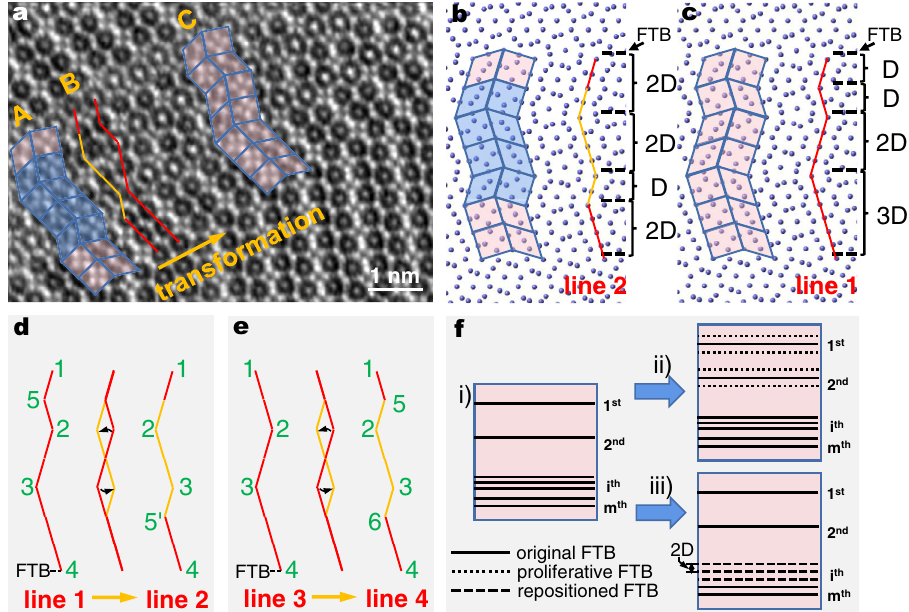
Fig. 5 The HAADF image and schematic illustration of the thickening process of intergrowth P phase. a The HAADF image projection along [1-10] μ showing the thickening process of intergrowth P phase. The orange arrow in ( a ) marks the direction of the progressive transformation. Regions A – C corresponds to the three sequential stages of transformation. b , c Atomic models corresponding to the regions A and C in ( a ), respectively. The differences between the atomic arrangement in region A and that in region C are indicated by the blue block layer (thickness of 4D) in ( b ). The black dashed lines mark the interface position of the FTBs in ( b , c ) and the distances between two adjacent FTBs are added. The atomic structures of region C and A can also be simpli fi ed as line 1 and line 2, respectively. Their endpoints and turning points indicate the presence of the FTBs here, numbered by the green text in ( d ). d Schematic illustration of the location of FTBs changed by the transformation in ( a ). The FTB at number 5 transforms to perfect μ and an identical FTB appears at number 5 ’ . e The schematic example of the number of FTBs changed by the same transformation. The structure of line 3 is similar to that of line 1, only different at the top. f The brief schematic of the growth process of intergrowth P (or σ ) phase in μ phase. The schematic (i) in ( f ) shows that there are many randomly distributed original (110) FTBs in the parent μ phase, represented by the solid black lines, with a total number of m. Via the local atomic short-range diffusion at FTBs, n FTBs can proliferate to be 3n as illustrated by the fi rst and second FTB shown in (ii), and their distribution and spacing can also be regulated as illustrated by the i th and nearby FTBs shown in (iii). The new phase in schematic (iii) is an example of the P phase (FTBs with a spacing of 2D). If the new phase is σ phase, the spacing between FTBs is